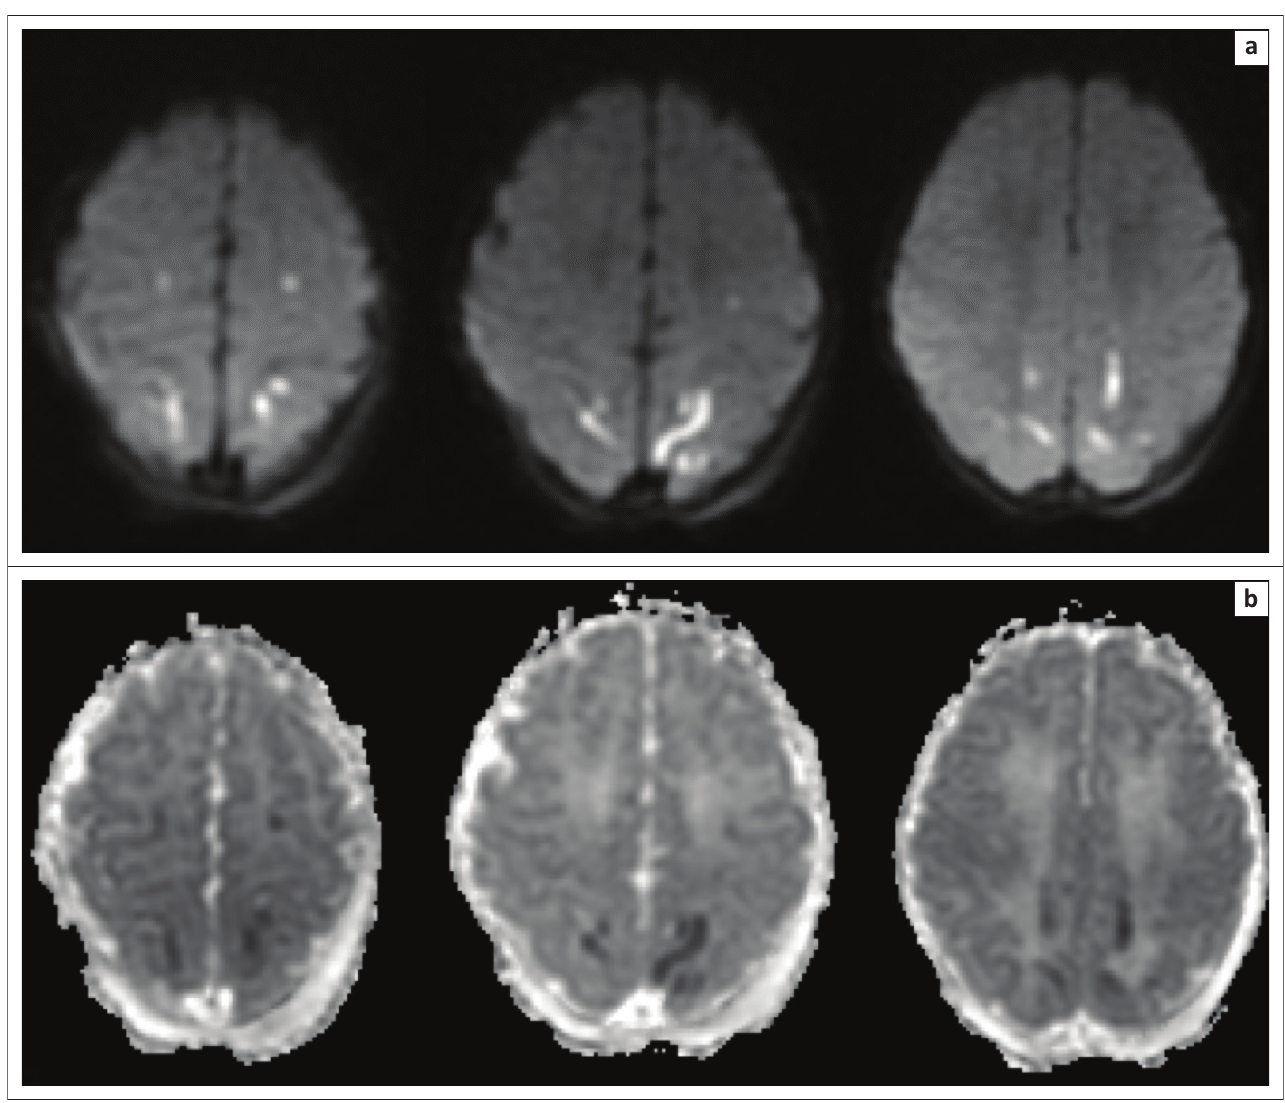
FIGURE 16: A 2-day-old baby boy presenting with grade 2 hypoxic ischemic brain injury. (a) The diffusion B-1000 trace sequences and (b) the corresponding ADC maps at each level. There are focal areas of restricted diffusion involving the parasagittal watershed zones of both cerebral